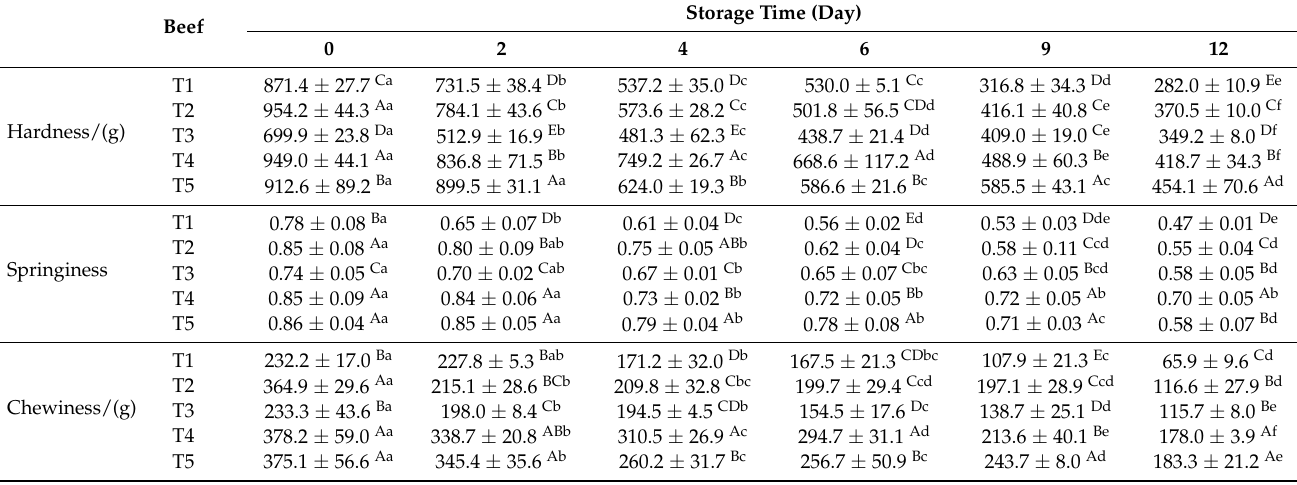
Table 2. The TPA texture of beef samples from different treatment groups during storage (mean ±